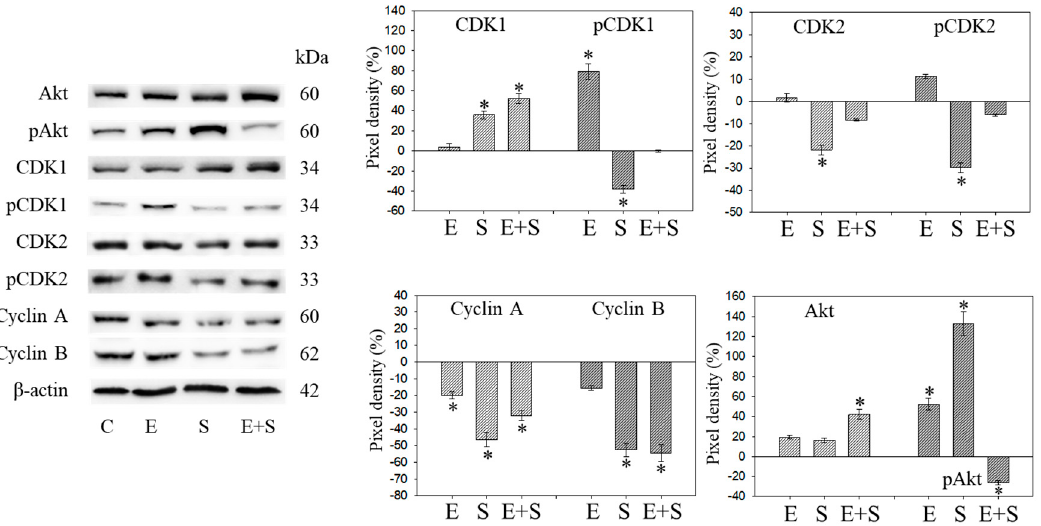
Figure 9. Protein profile of cell cycle regulating proteins (Akt, CDKs, Cyclins) after long-term exposure to 0.5 nM everolimus (E) or 2.5 µ M sulforaphane (S) or 0.5 nM everolimus + 2.5 µ M sulforaphane (E +